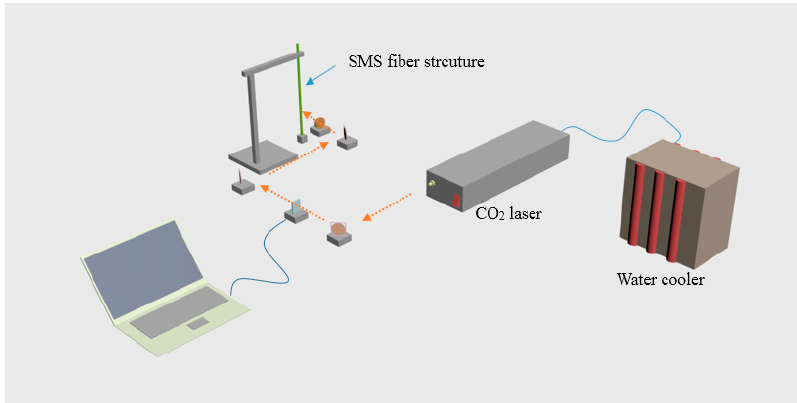
Figure 7. Schematic of experimental setup for fabricating a tapered MMF tip.